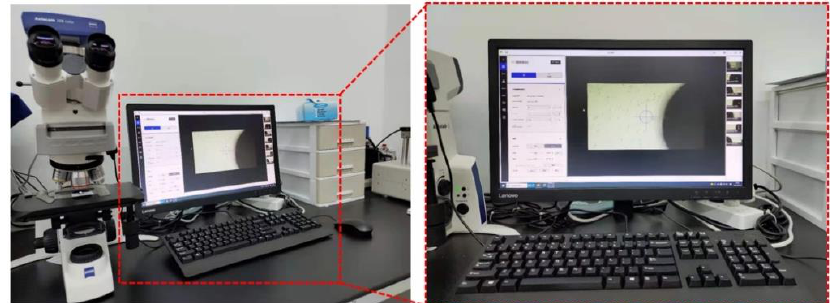
Figure 6. Microscope for observing fatigue crack remodeling.